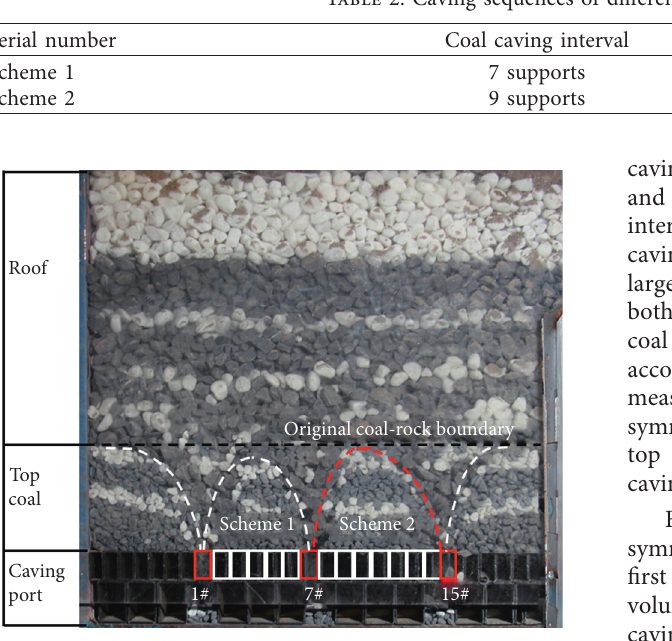
Figure 5: Initial state of physical similarity model. Table 2: Caving sequences of different coal caving methods.